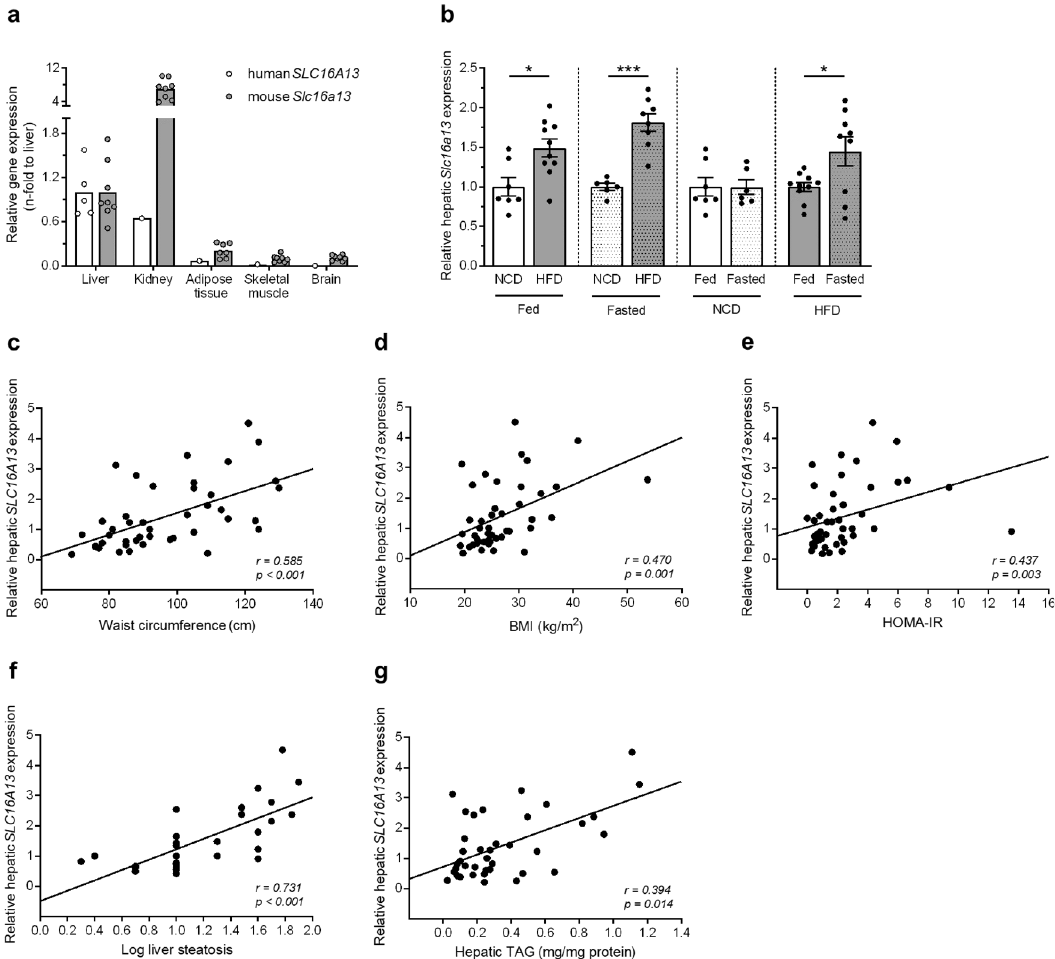
Fig. 1 SLC16A13 expression in humans and mice. a SLC16A13 mRNA expression in one human sampler relative to mRNA expression in the liver ( n = 5). Slc16a13 mRNA expression in mice fed normal-chow diet ( n = 7 – 8) relative to mRNA expression in the liver. b Relative hepatic Slc16a13 mRNA expression in C57BL/6J mice fed with NCD or HFD for 15 weeks. Animals are fed ( n = 7 – 10 per group) or fasted for 16h ( n = 6 – 9 per group). a , b Bars represent means ± SEM. * p < 0.05, ** p < 0.01 determined using two-tailed unpaired Student ’ s t -test. c – g Correlation of relative hepatic SLC16A13 mRNA expression and adiposity-related parameters in humans. Linear regression curve is shown. c Waist circumference, d BMI (Body Mass Index), e HOMA-IR (Homeostatic Model Assessment for Insulin Resistance), f Logarithm liver steatosis, g Hepatic TAG (triacyl g lycerol). r = Spearman-Rho correlation coef fi